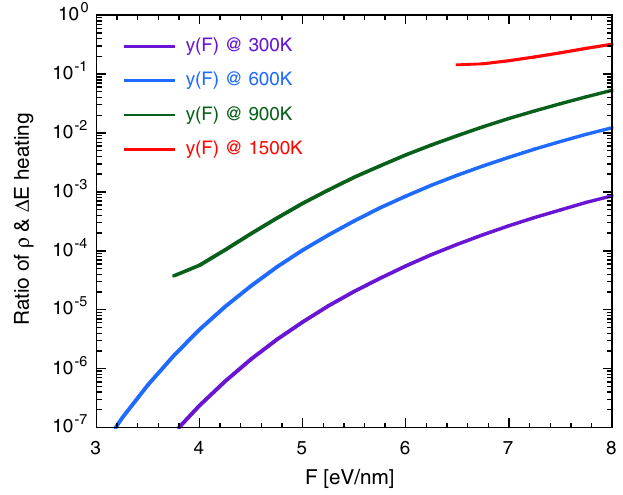
FIG. 15. (Color) Ratio of resistive heating to Nottingham heat- ing (not cooling) for different temperatures as a function of apex